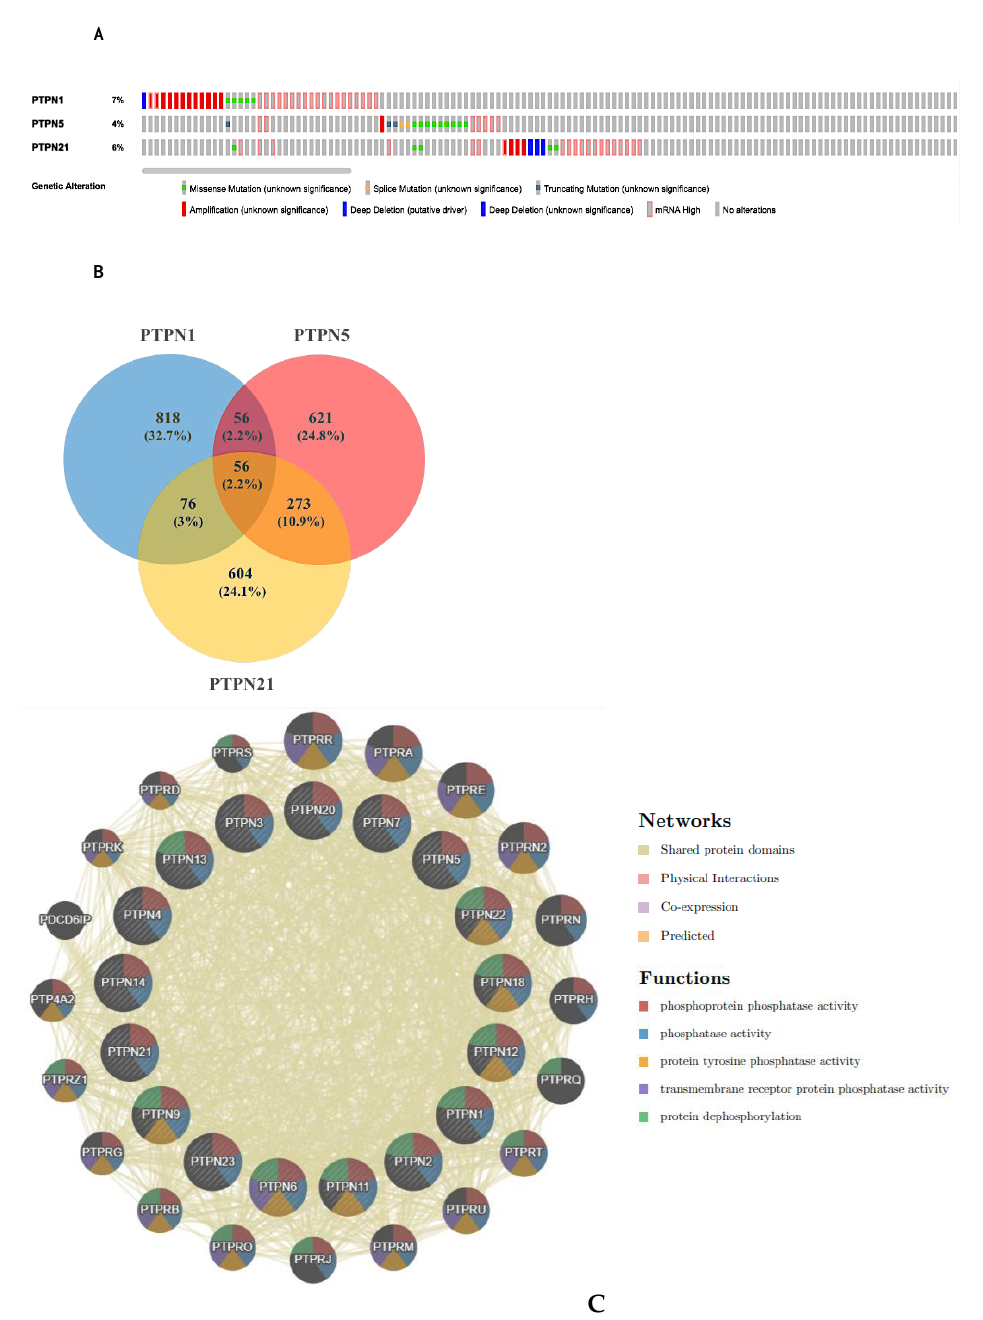
Figure 6. Genetic alterations, co-expression, and functional enrichment analysis of protein tyrosine phosphatase non-receptor type ( PTPN ) family members in lung adenocarcinoma (LUAD) patients. ( A ) Genetic alterations in PTPN family members in LUAD (from cBioPortal). ( B , C ) Common genes among PTPN1 , PTPN5 , and PTPN21 (from Venny 2.0).